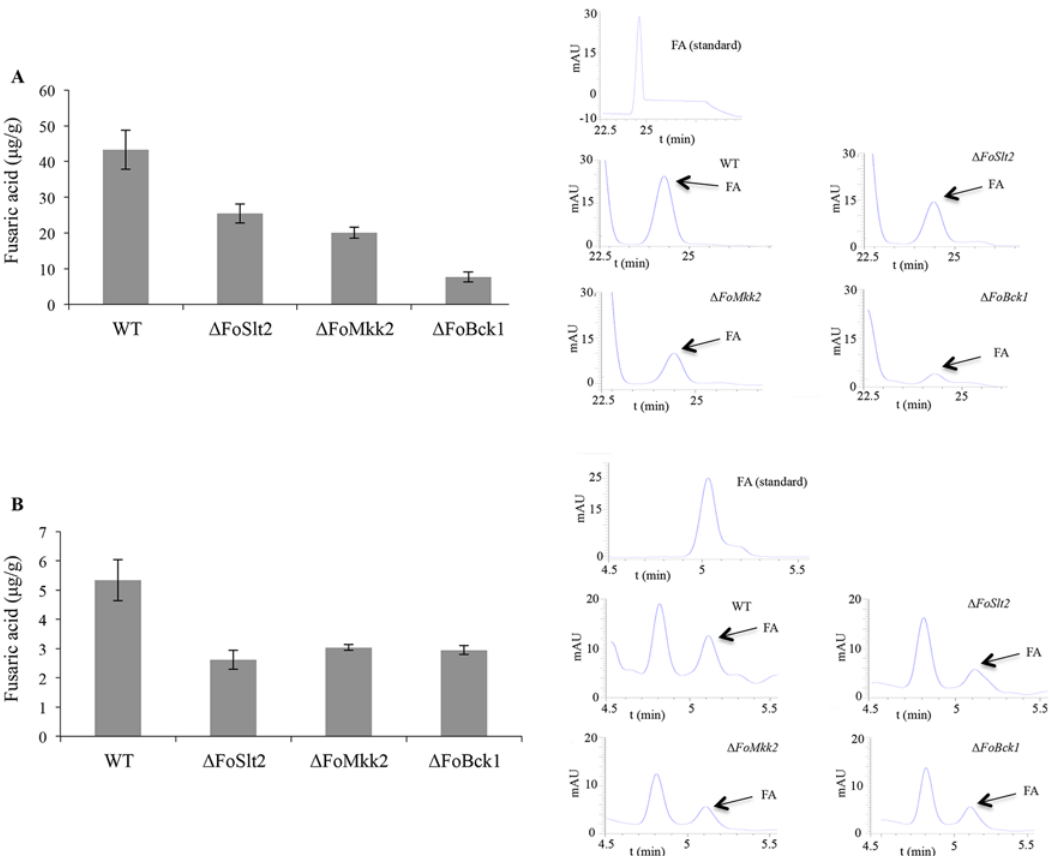
Fig 8. Fusaric acid (FA) production was reduced in mutants Δ FoSlt2 , Δ FoMkk2 and Δ FoBck1 . (A) Fusaric acid production from cultures of the indicated strains in Czapek dox medium was analysed by High Performance Liquid Chromatography (HPLC). Fusaric acid levels are represented in μ g g -1 mycelial dry weight. (B) Fusaric acid production from the crude mycotoxin extracted of the indicated strains in grains cultures was analysed with HPLC. Fusaric acid levels are represented in μ g g -1 grains cultures dry weight. Error bars indicate the standard error from three